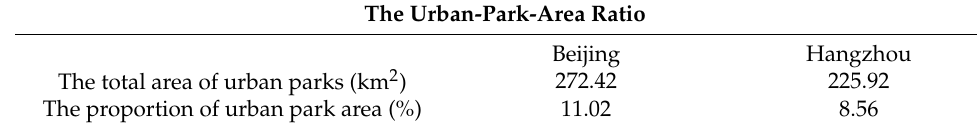
Table 6. The urban park area